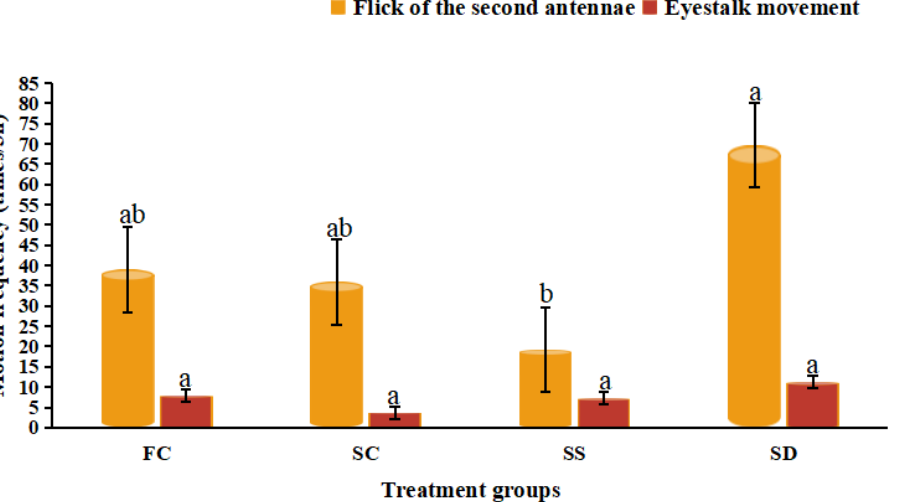
Figure 5. Eyestalk movement and flick of the second antennae in Eriocheir sinensis during 3 h exposure in four treatment groups (FC: freshwater control group; SC: salinity control group; SS: salinity surge group; SD: salinity dip group). Bars with the same lowercase letters on the top indicate insignificant differences ( p > 0.05), and bars with different letters on the top indicate significant differences ( p < 0.05).